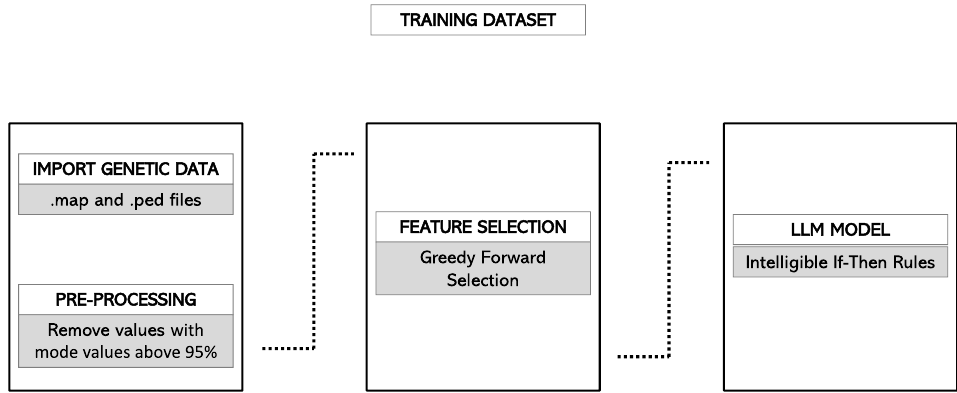
Figure 1. Classification pipeline in the Rulex environment. Information is imported and parsed and then entered into a feature selection branch working in cross-validation. Several hyperparameters are evaluated, and their value can be tuned. Finally, the LLM model generates if-then rules for classification. After completing the pre-defined number of runs, the process generates a number of metrics, including accuracy measures and the feature ranking of attributes. Abbreviations: LLM, Logic Learning Machine.